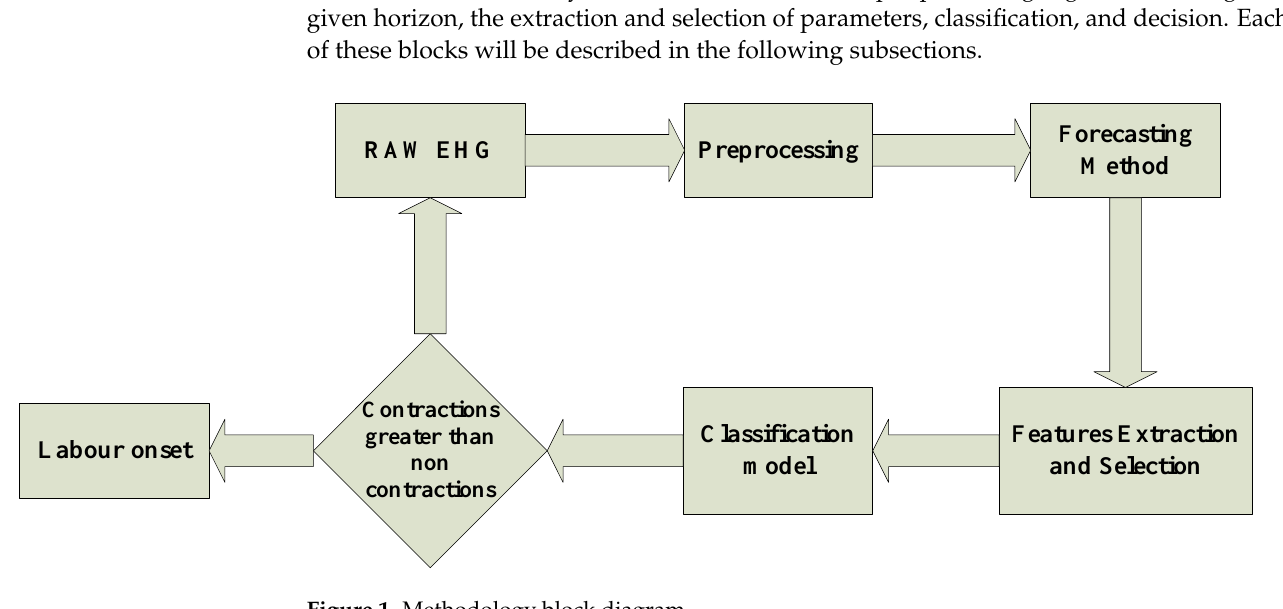
Figure 1. Methodology block diagram .